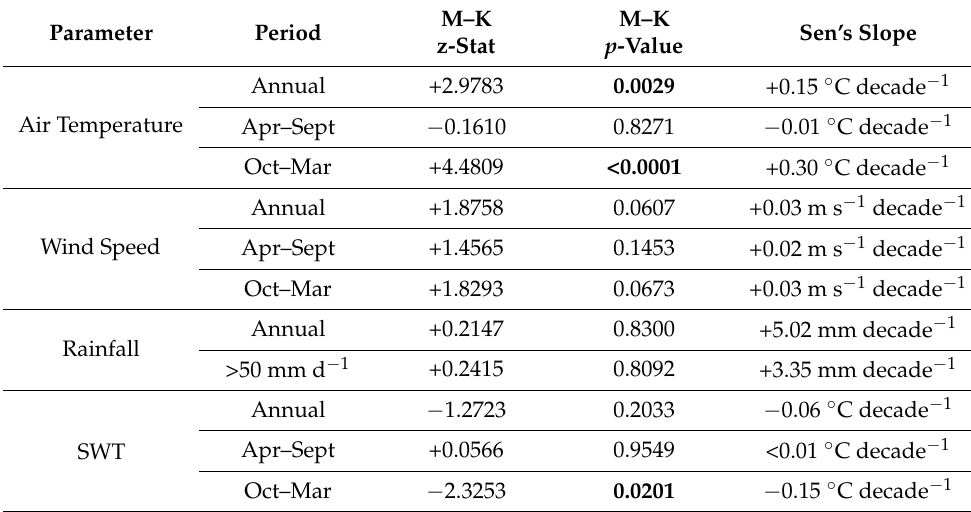
Table 2. Results of the Mann–Kendall (M–K) test at α = 0.05 for long-term values of air temperature, wind speed, rainfall (basin average), and SWT. Significantly different p -values are in bold characters. M–K Parameter Period z-Stat